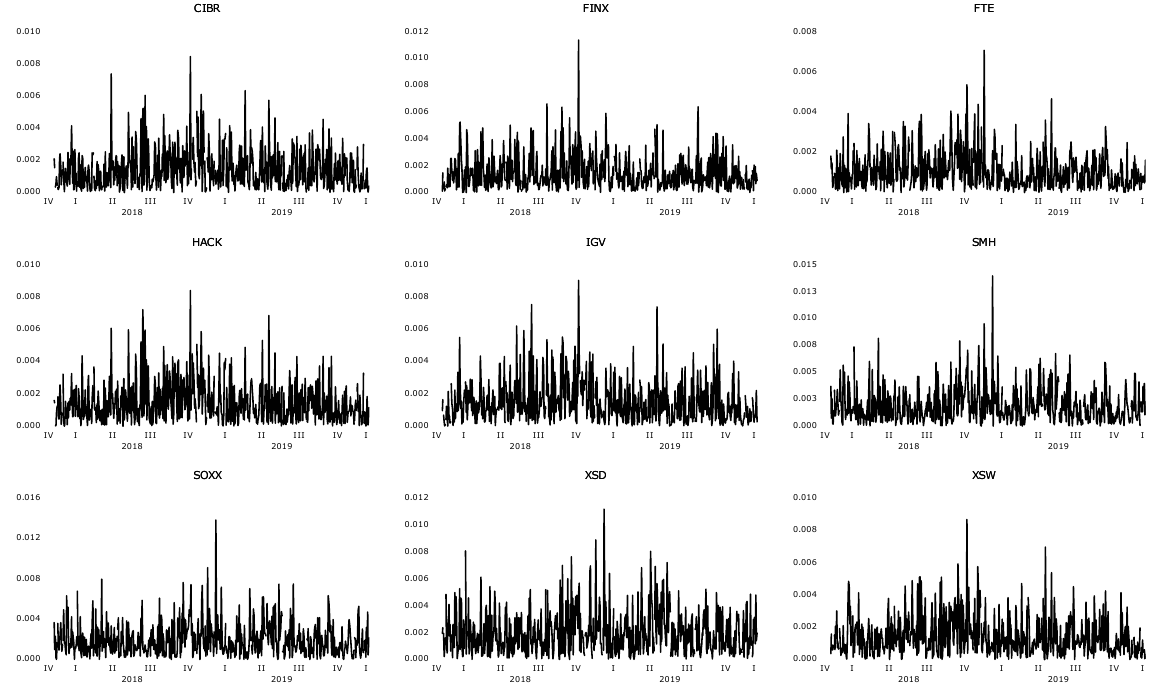
Figure 2. Daily Idiosyncratic Volatility Measure, high-tech ETFs (12/01/2017-1/31/2020).